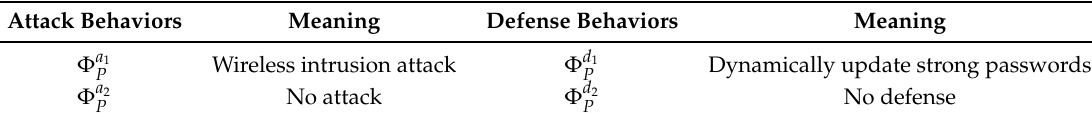
Table 1. Attack–defense behaviors in the penetration phase.